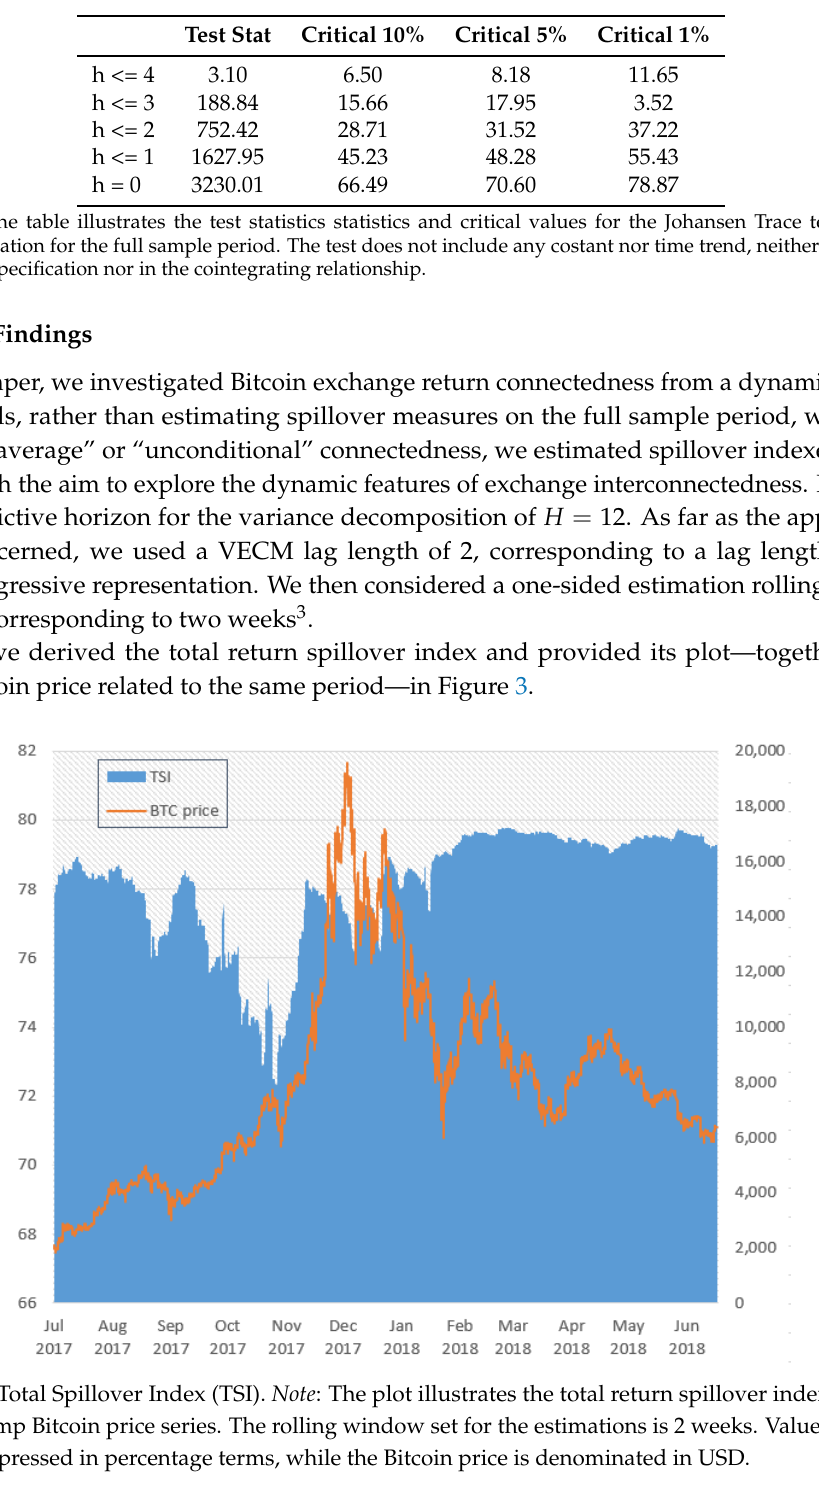
Table 5. Cointegration (Johansen Trace test).